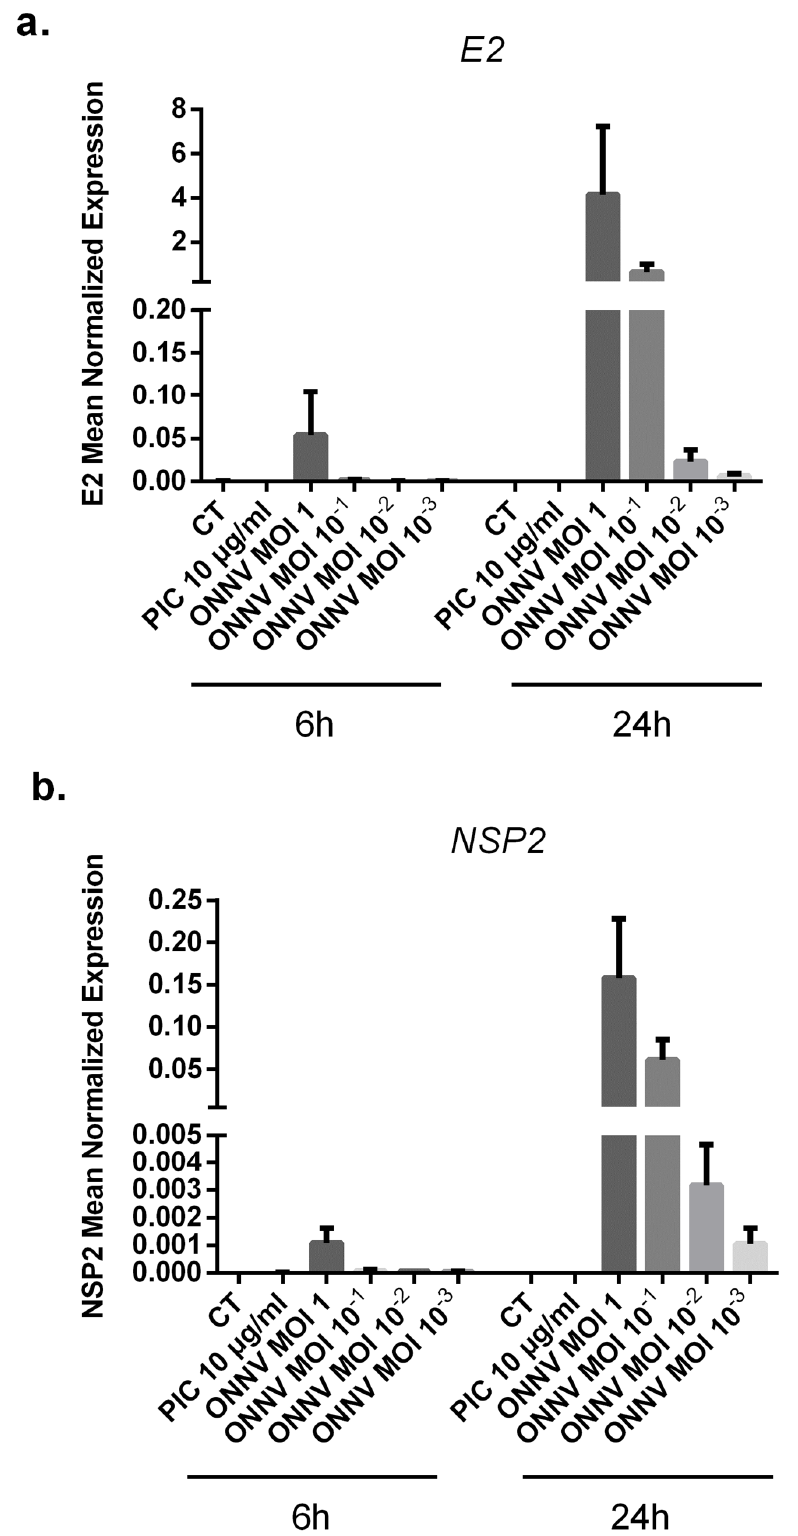
Figure 2. ONNV infects and replicates effectively in SC. ( a ) Relative expression of viral E2 and ( b ) NSP2 from infected SC with different MOIs of ONNV (from MOI 10 − 3 to 1) for 6 h and 24 h (qRT ‐ PCR data). All experiments were done in triplicates.